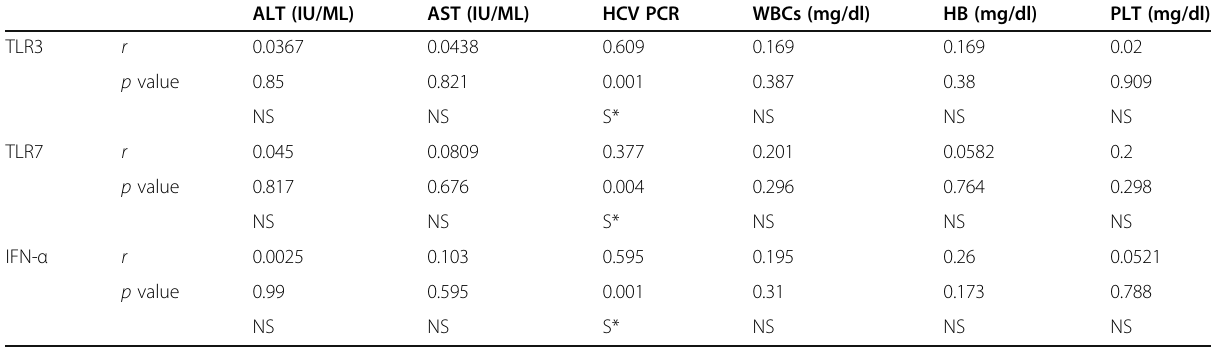
Table 1 The correlation among TLR3, TLR7, IFN- α , and laboratory and biochemical parameter findings in the chronic HCV